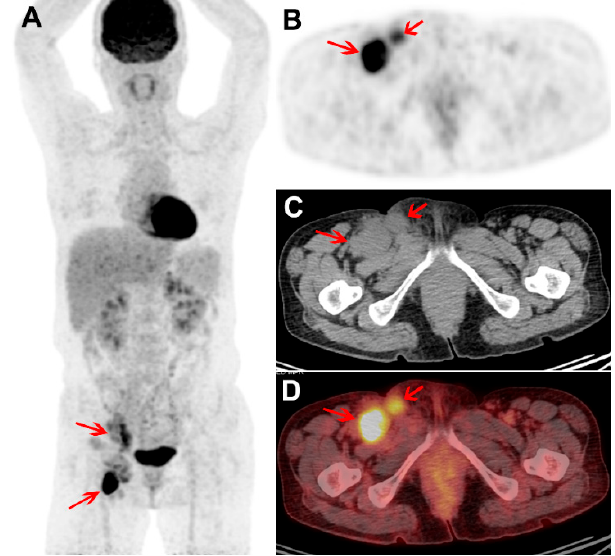
Figure 2. Treatment naïve FDG PET/CT images of a male with plasma cell subtype of multicentric CD (MCD). Maximum intensity projection PET ( A ) and trans-axial PET, CT, and fused PET/CT images ( B, C, D ) show intense FDG uptake in enlarged right external iliac and inguinal nodes (arrows; SUVmax 10.2 and T/L ratio 4.9). The FDG uptake intensity is high, but only two nodal stations were involved. The hemoglobin, platelet, albumin, and hs-CRP levels were within normal range. The patient received chemotherapy and siltuximab. Four years after the PET/CT study, the patient currently remains symptom free.